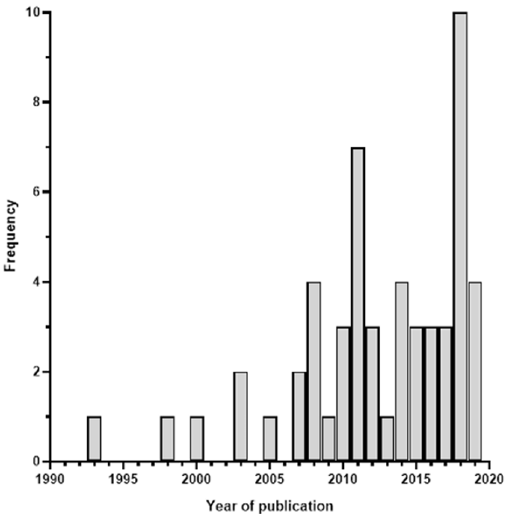
Figure 2. Number of articles and the year of publication.